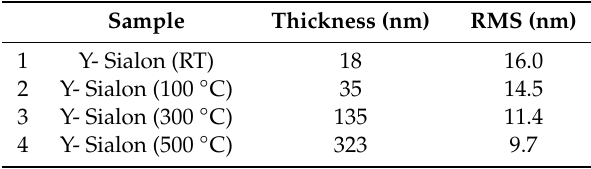
Table 2. Physical properties of Y / Sialon thin films prepared using PLD technique at various deposition temperatures.